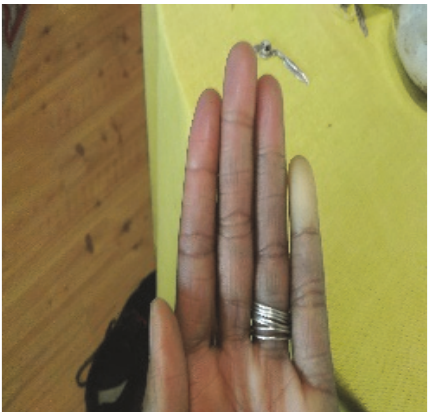
Figure 1: Pallor of the distal fingers of the left hand.